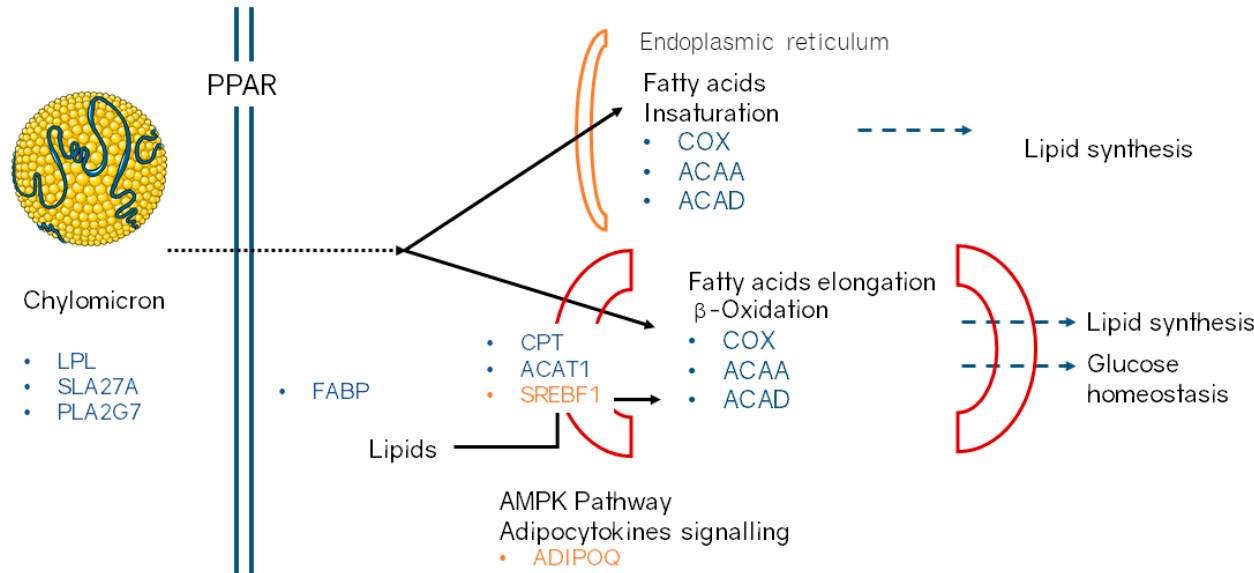
Figure 1. Differentially expressed genes clustered according to their associated metabolic pathways and cell location. We colored upregulated genes in Retinto variety in blue and downregulated genes in orange.